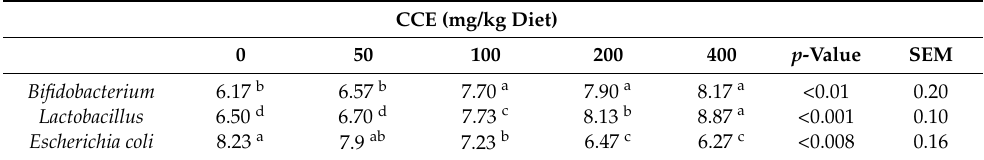
Table 6. Effect of different levels of Cornelian cherry extract (CCE) on cecal microorganisms (Log 10 cfu/g fresh digesta) of broiler chickens at slaughter. CCE (mg/kg Diet) 0 50 100